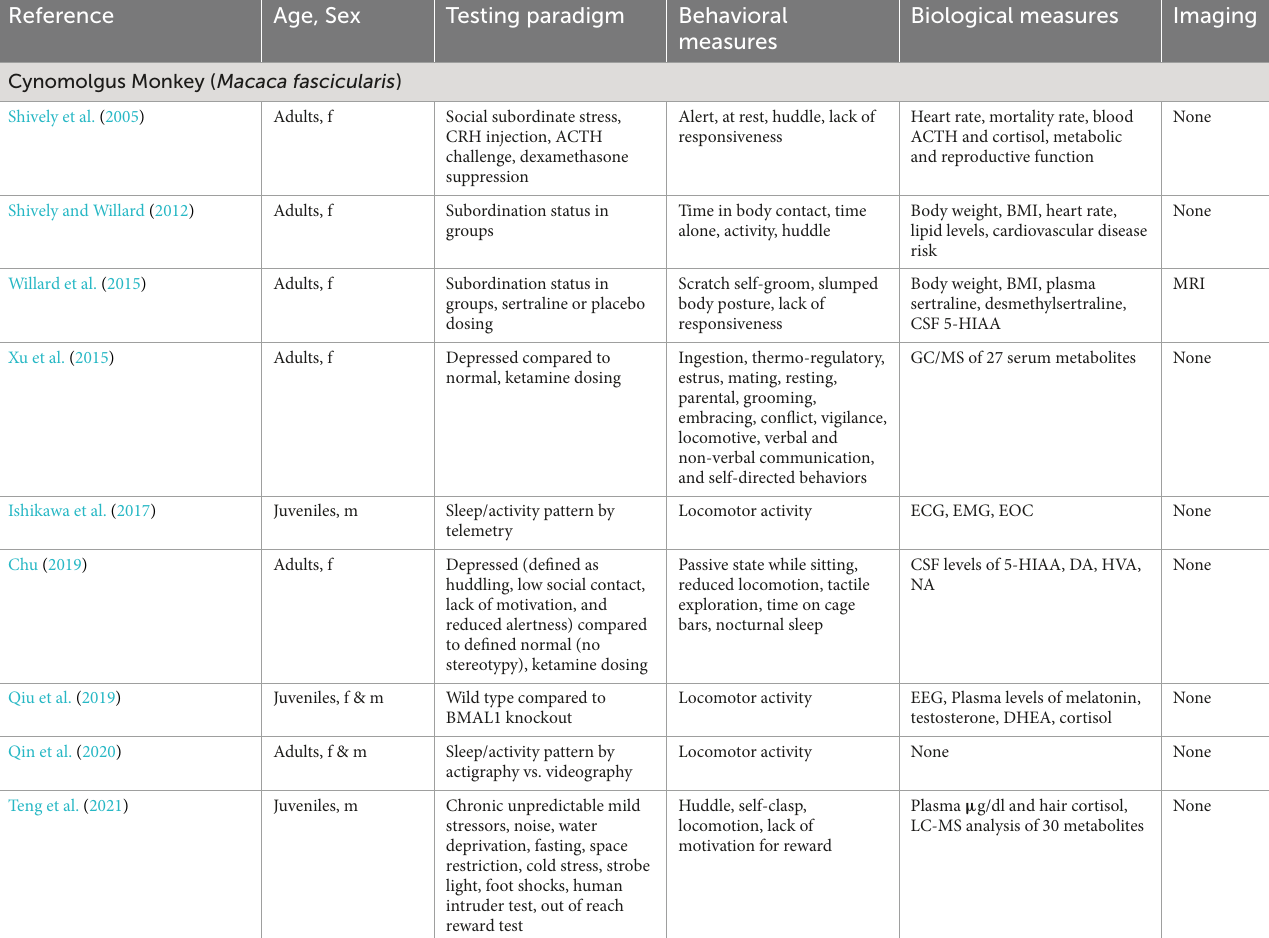
TABLE 4 Selected peer-reviewed publications describing methods of evaluation of depression- and anxiety-like behaviors in cynomolgus macaques (infant = 0–1 y; juvenile = 1–4 y; adult = 4–25